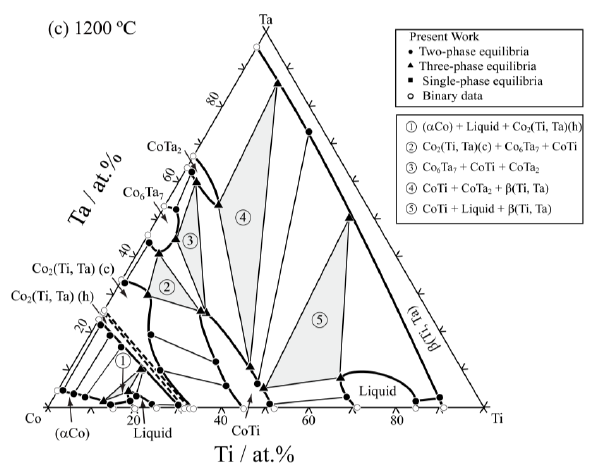
Figure 4. Experimentally determined isothermal sections of the Co-Ti-Ta system at: ( a ) 1000 °C; ( b ) 1100 °C; and ( c ) 1200 °C.